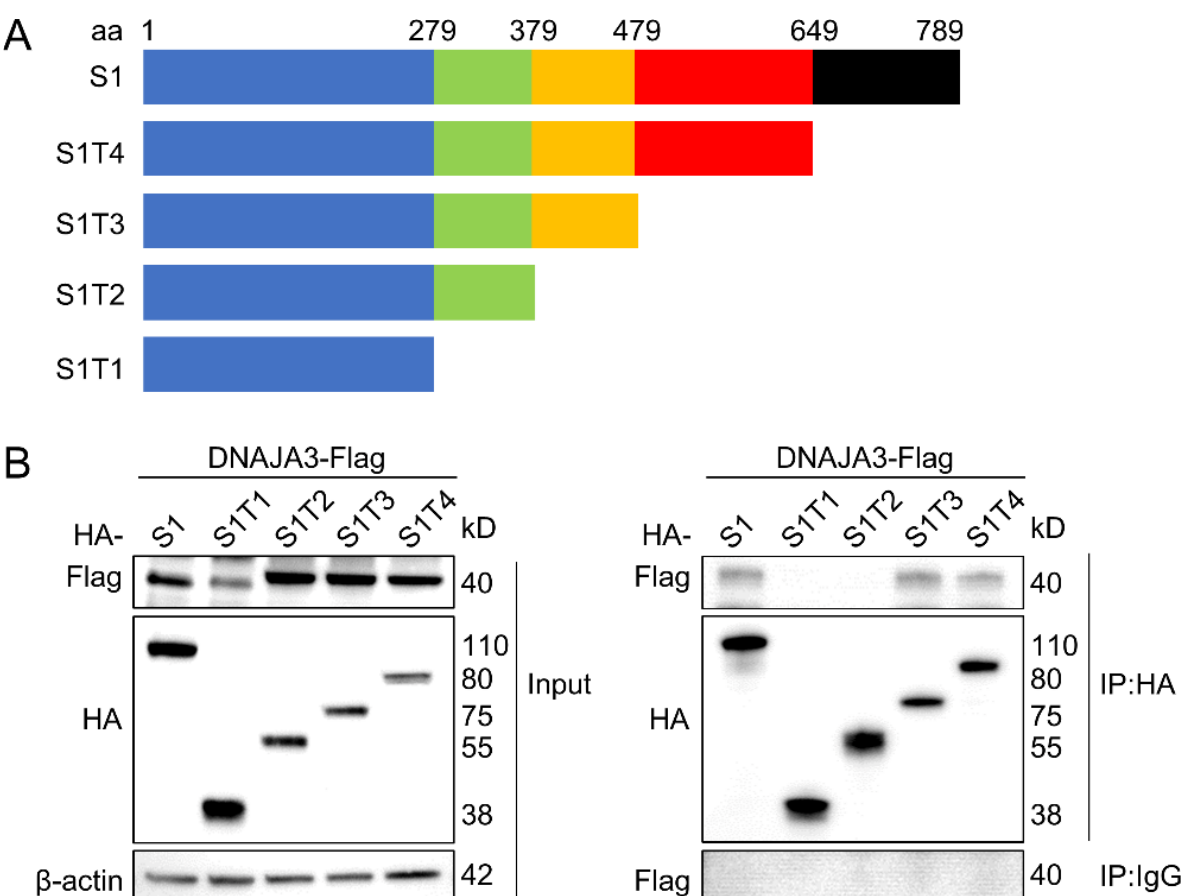
Figure 2. The middle fragment of PEDV S1 between aa379 and aa479 was the region to interact with DNAJA3. ( A ): Schematic representation of the full-length S1 protein and its truncated proteins. ( B ): Co-IP detection of the interaction of DNAJA3 with S1 protein region in the IPEC-J2 cells co-trans- fected with pCMV-DNAJA3-Flag and plasmids expressing S1 full-length or its truncated proteins.